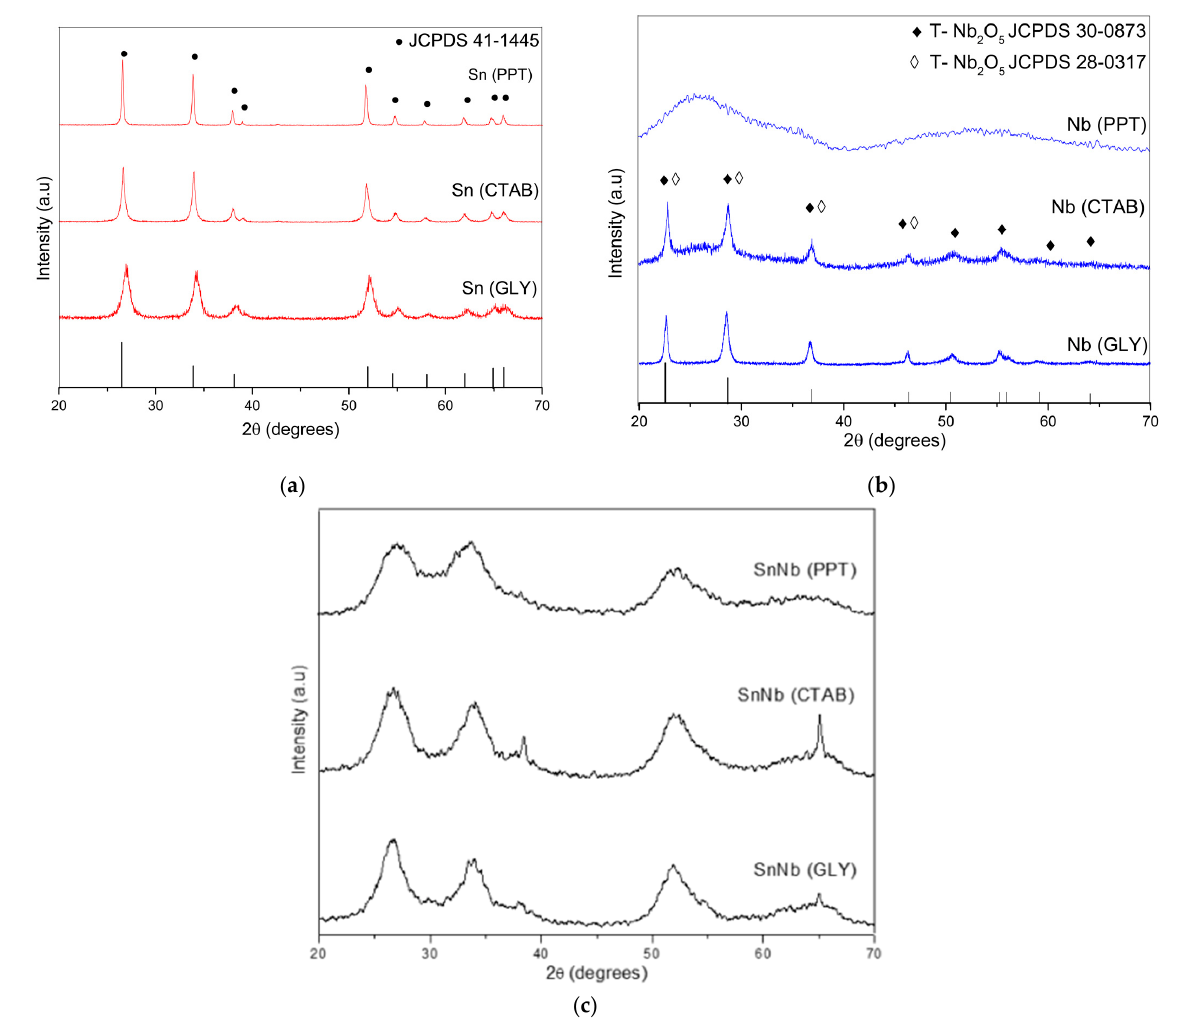
Figure 1. XRD patterns of the catalysts: ( a ) Sn(PPT), Sn(CTAB) and Sn(GLY); ( b ) Nb(PPT), Nb(CTAB) and Nb(GLY); and ( c ) SnNb(PPT), SnNb(CTAB) and SnNb(GLY).